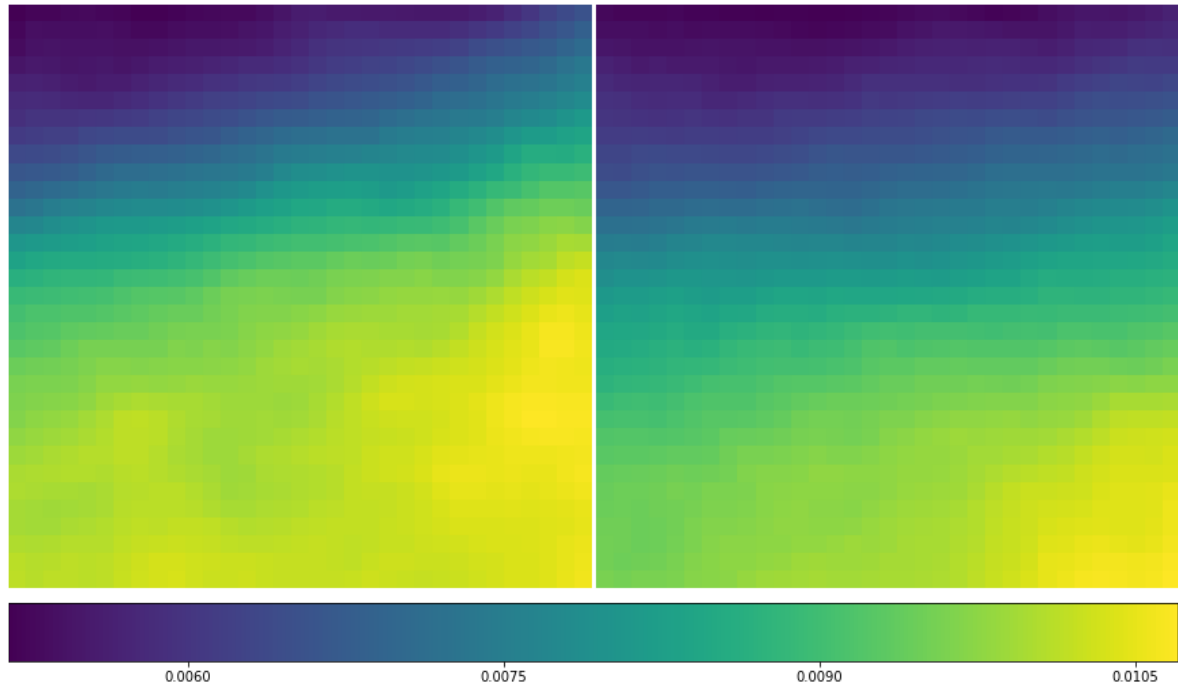
Figure 8. Distribution of mean specific humidity (q) (unit: kg/kg) at 850 hPa layer for RI ( left ) and non-RI cases ( right ) based on 584 RI cases and randomly selected 584 non-RI samples. The area covers the 33 × 33 (approximately 1300 km × 1300 km) Interim data grids centered on the TC location based on the NHC best track data. The orientation is the same as the data, i.e., the X-axis is aligned with horizontal direction or roughly longitude and Y-axis is aligned with meridional direction or roughly